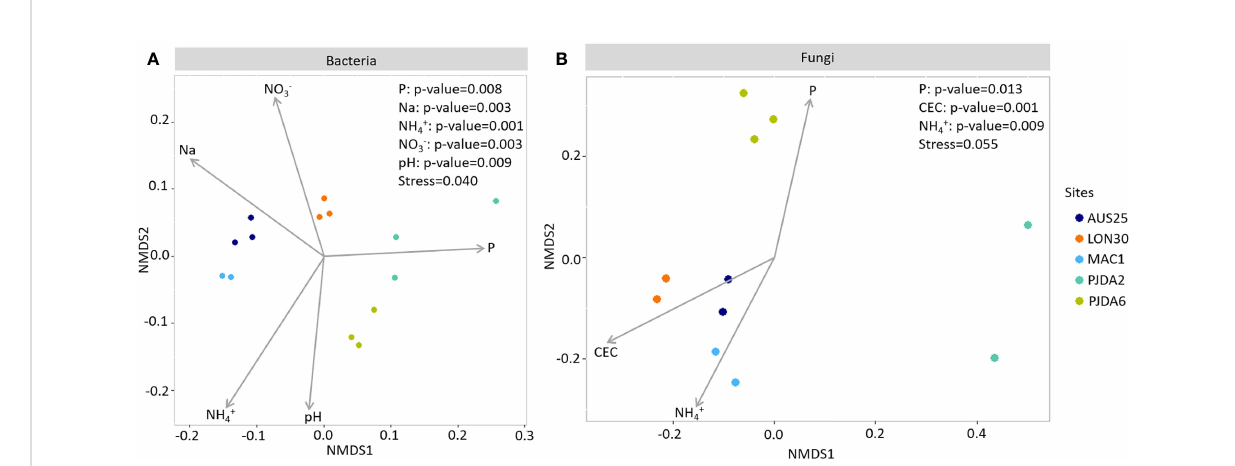
FIGURE 4 Non-metric multidimensional scaling (NMDS) ordination showing signi fi cant (p < 0.01) relationships between soil physico-chemical properties and the composition of (A) bacterial and (B) fungal communities in the bulk soils of each